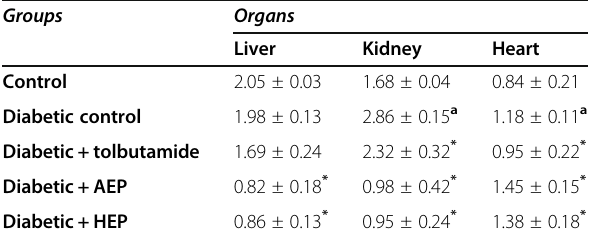
Table 6 Effect of peel extracts of I. wombolu on hydroperoxides level (mM hydroperoxides / 100 g of tissue) liver, kidney,